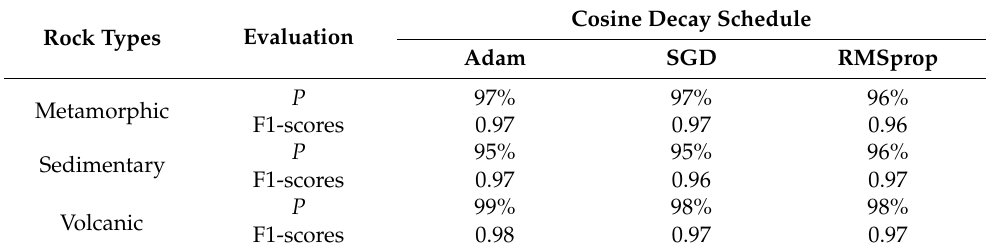
Table 4. Detailed classification results for all rock types.